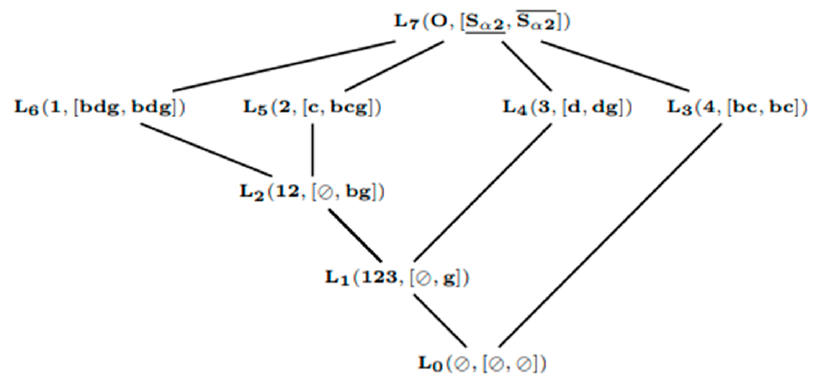
Figure 4. Reduct S α 2 . Figure 4. Reduct 𝑆 (cid:3080)(cid:2870) . Consider a reduct S α 3 = { d , f , g } whose corresponding concept lattice is L ( O , M , R nS Then L [ O 0 ] = ( ∅ , [ ∅ , ∅ ]) , L [ O 1 ] = ( 4, [ f , f ]) , L [ O 2 ] = ( 1, [ dg , dg ]) , ( 2, [ ∅ , f g ]) , ( 3, [ d , dg ]) , (cid:3)(cid:1) (cid:0) (cid:2) O , B , B and L ( O 3 ) = . Hence, this generates the set ( ∅ , [ ∅ , ∅ ]) , ( 123, [ ∅ , g ]) , ( 4, [ f , f ]) , ( 3, [ d , dg ]) , ( 2, [ ∅ , f g ]) , (cid:3)(cid:1) ( 1, [ dg , dg ]) and (cid:0) O , (cid:2) S α 3 , S α 3 and Figure 5 expressions the hasse